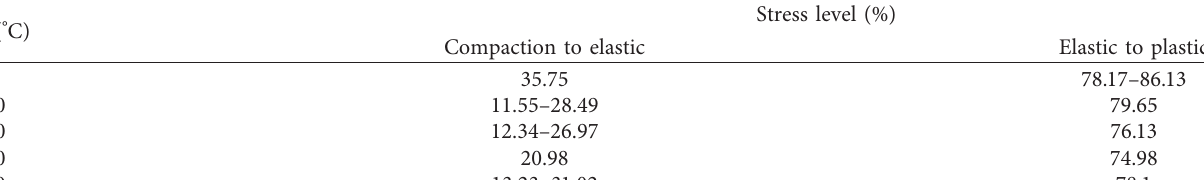
Table 3: Statistics of the incremental ratio of strain to axial pressure peak.